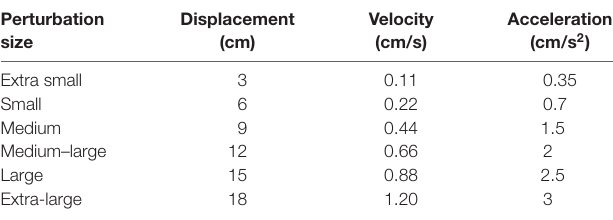
TABLE 2 | Details of the perturbation parameters that were used in the pre-testing and post-testing